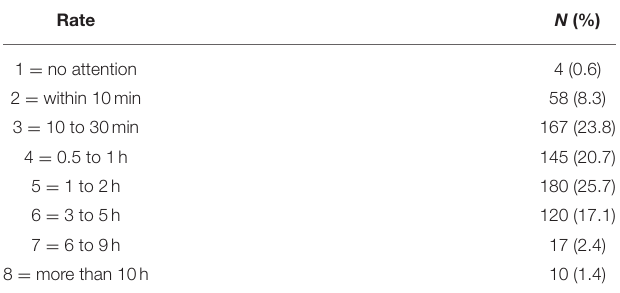
TABLE 1 | Distribution of participants’ duration of attention to pandemic